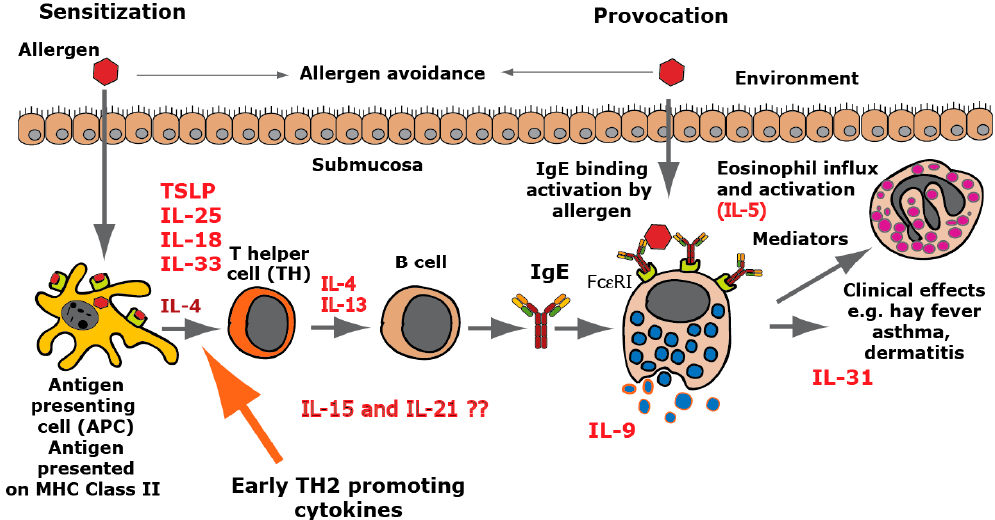
Figure 7. TH2-inducing cytokines in allergy development. A number of cytokines have been shown to be potent inducers of TH2-mediated immunity. The most well characterized are thymic stromal lymphopoietin (TSLP), IL-33, IL-18, IL-25, and IL-4. IL-18 has been shown to be a potent inducer of TH2-mediated immunity when present alone and not in combination with IL-12. Interestingly when present together with IL-12, IL-18 acts instead as an enhancer of TH1-mediated immunity [40]. IL-4 and IL-13 are the only two cytokines known to induce isotype switching in B cells to IgE [41]. IL-5 is important for eosinophil infiltration activation and proliferation, and IL-31 acts as an inducer of itch in skin with atopic dermatitis. IL-9 is, in mice, an inducer of mucosal mast cell differentiation [42]. Both IL-15 and IL-21 have been found to have TH2-promoting activity as described in the text. Cleavage of the TH2-initiating early cytokines would most likely result in a dampening effect on TH2-mediated immunity.